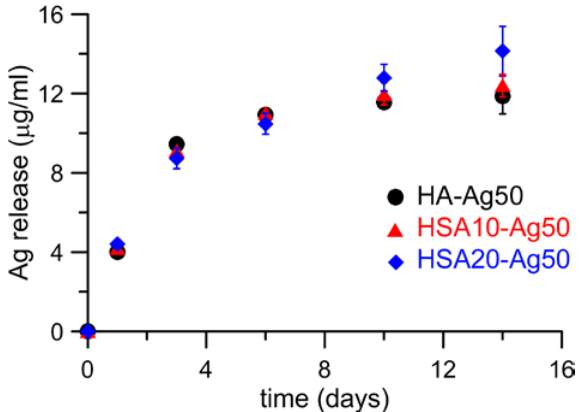
Figure 6. Silver cumulative release from HA-Ag50, HSA10-Ag50, and HSA20-Ag50 as a function of time.